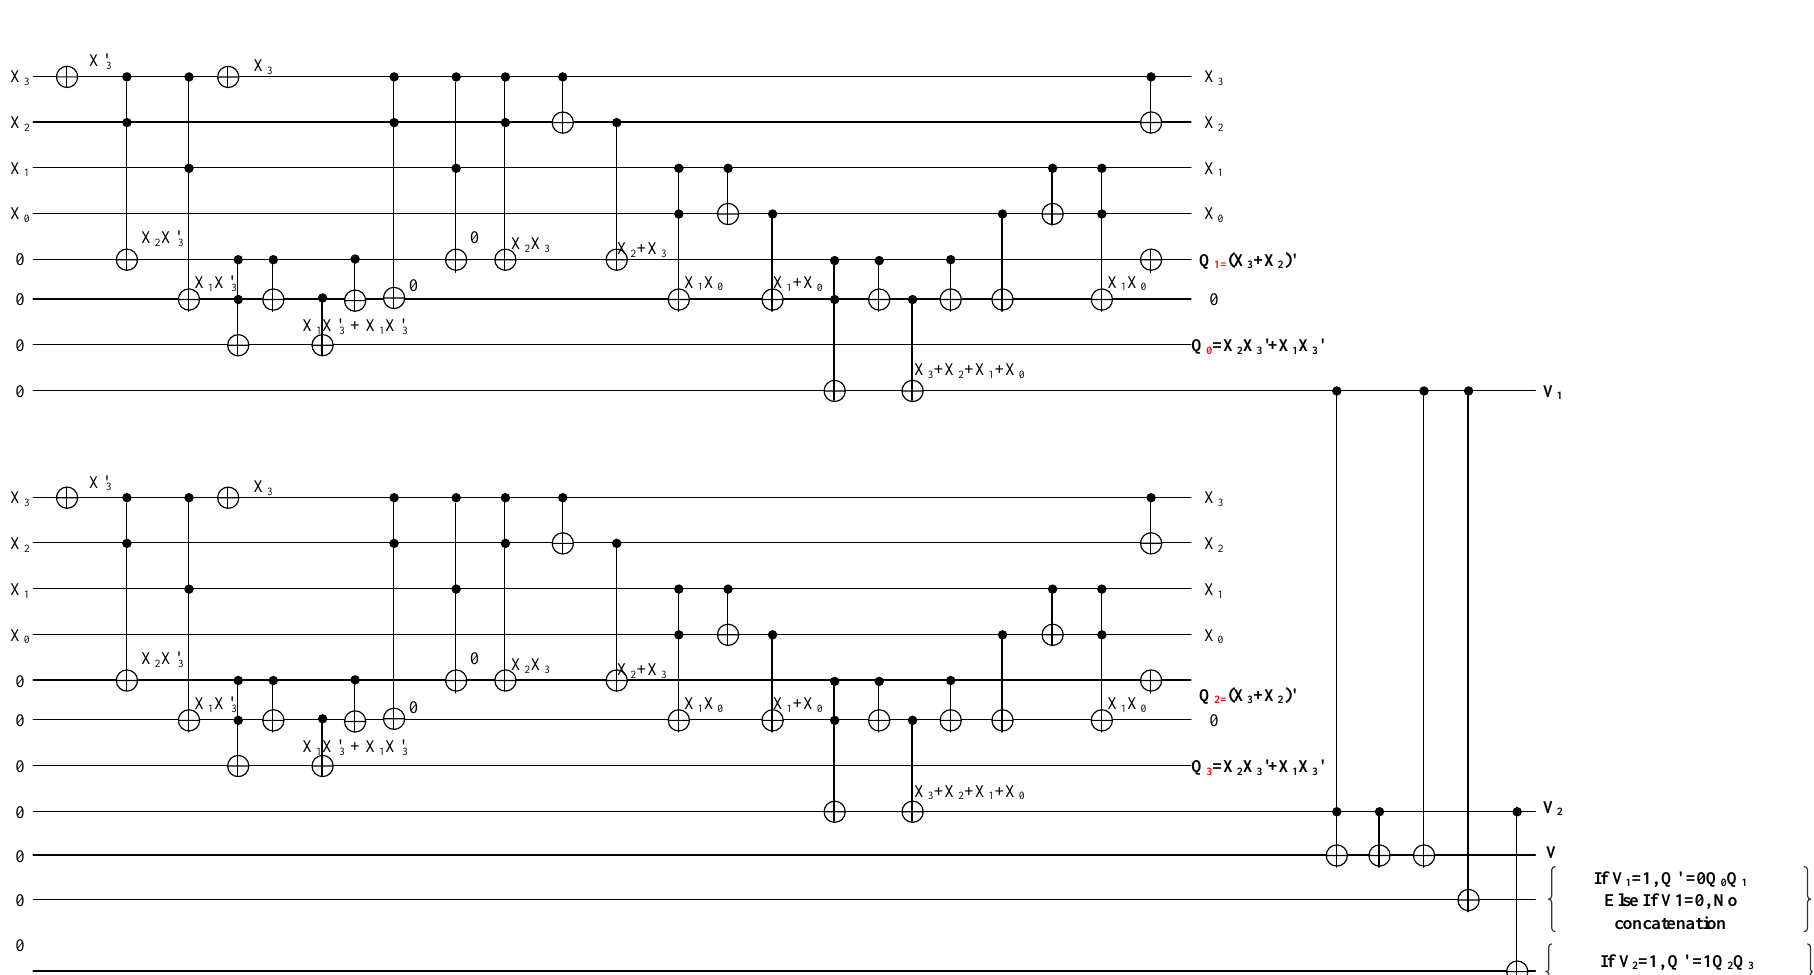
Figure 9. Proposed 8-qubit quantum Leading zero